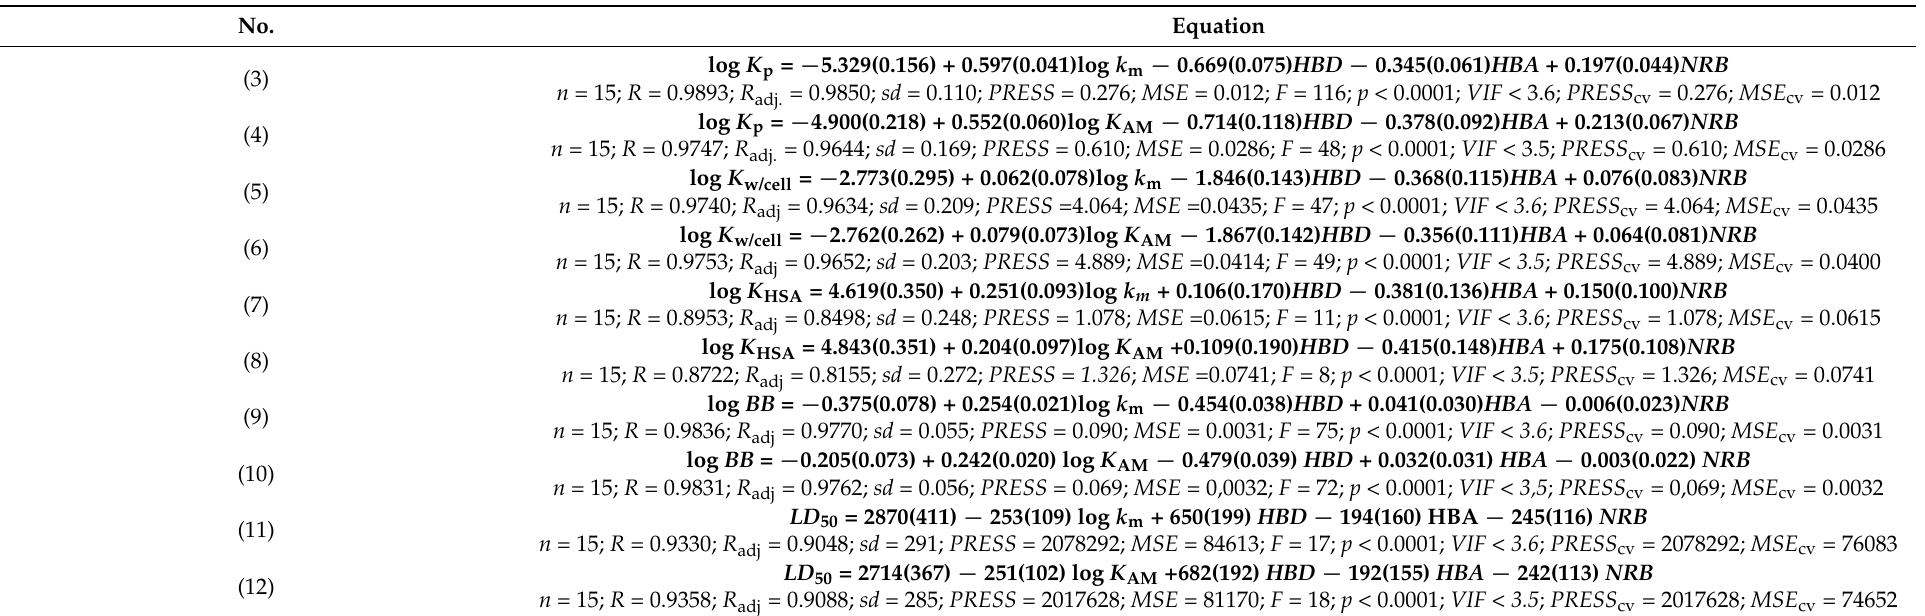
Table 3. The established quantitative structure–activity relationships: n —number of observations, R —coefficient of determination, R adj. —adjusted coefficient of determination, sd —standard deviation, F -value, p —probability value, VIF —variance inflation factor, PRESS —predicted residual sum of squares, MSE —mean square error,